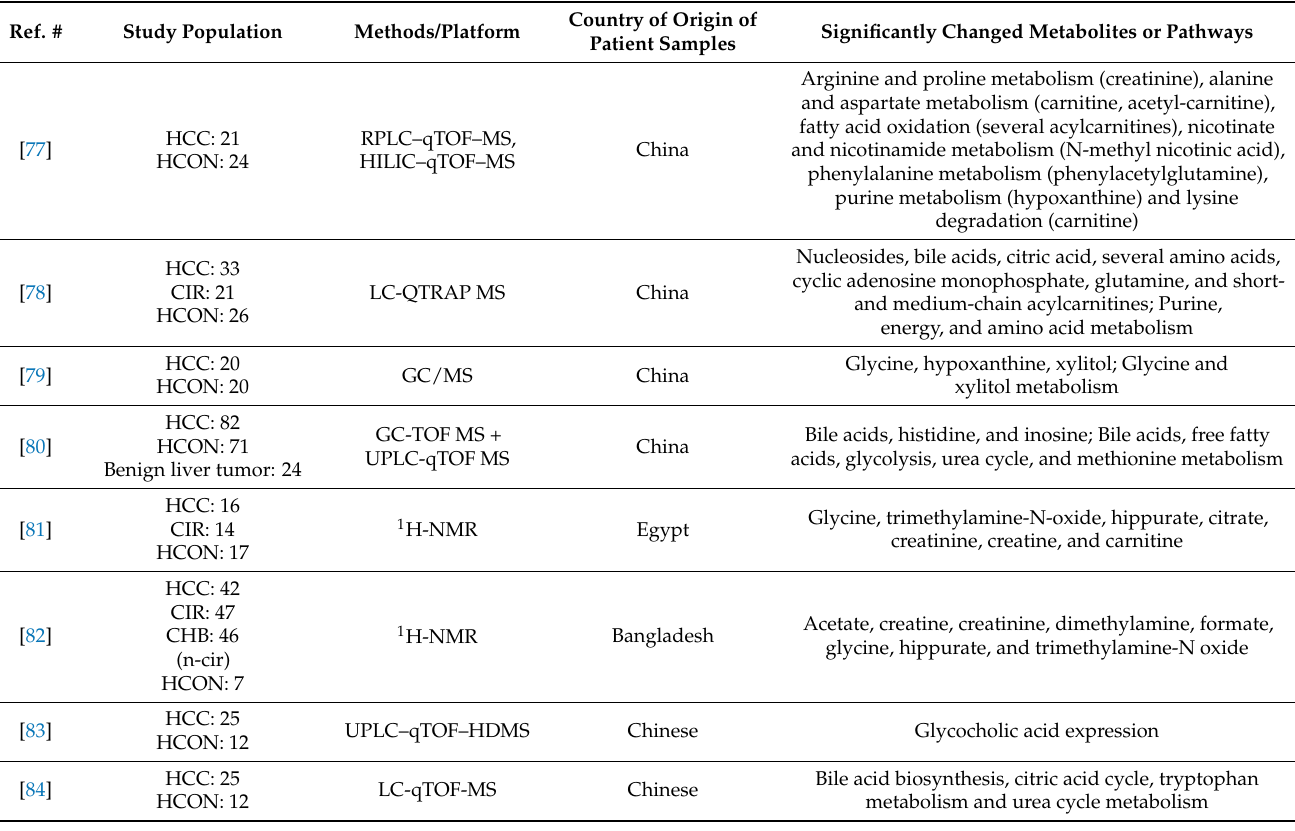
Table 3. Summary of urine-based